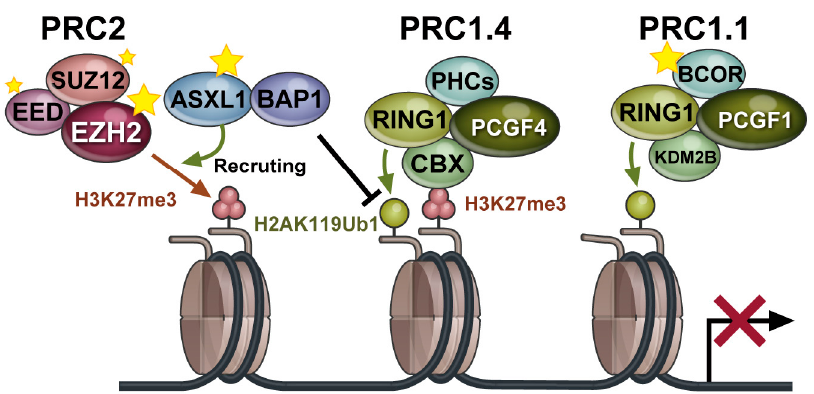
Figure 1. Polycomb repressive complexes (PRCs) are multiprotein complexes that play important roles in the repression of target genes through chromatin modifications. PRC components that are targeted by somatic gene mutations are indicated by stars. Black T arrow indicates inhibition of ubiquitination at H2K119.